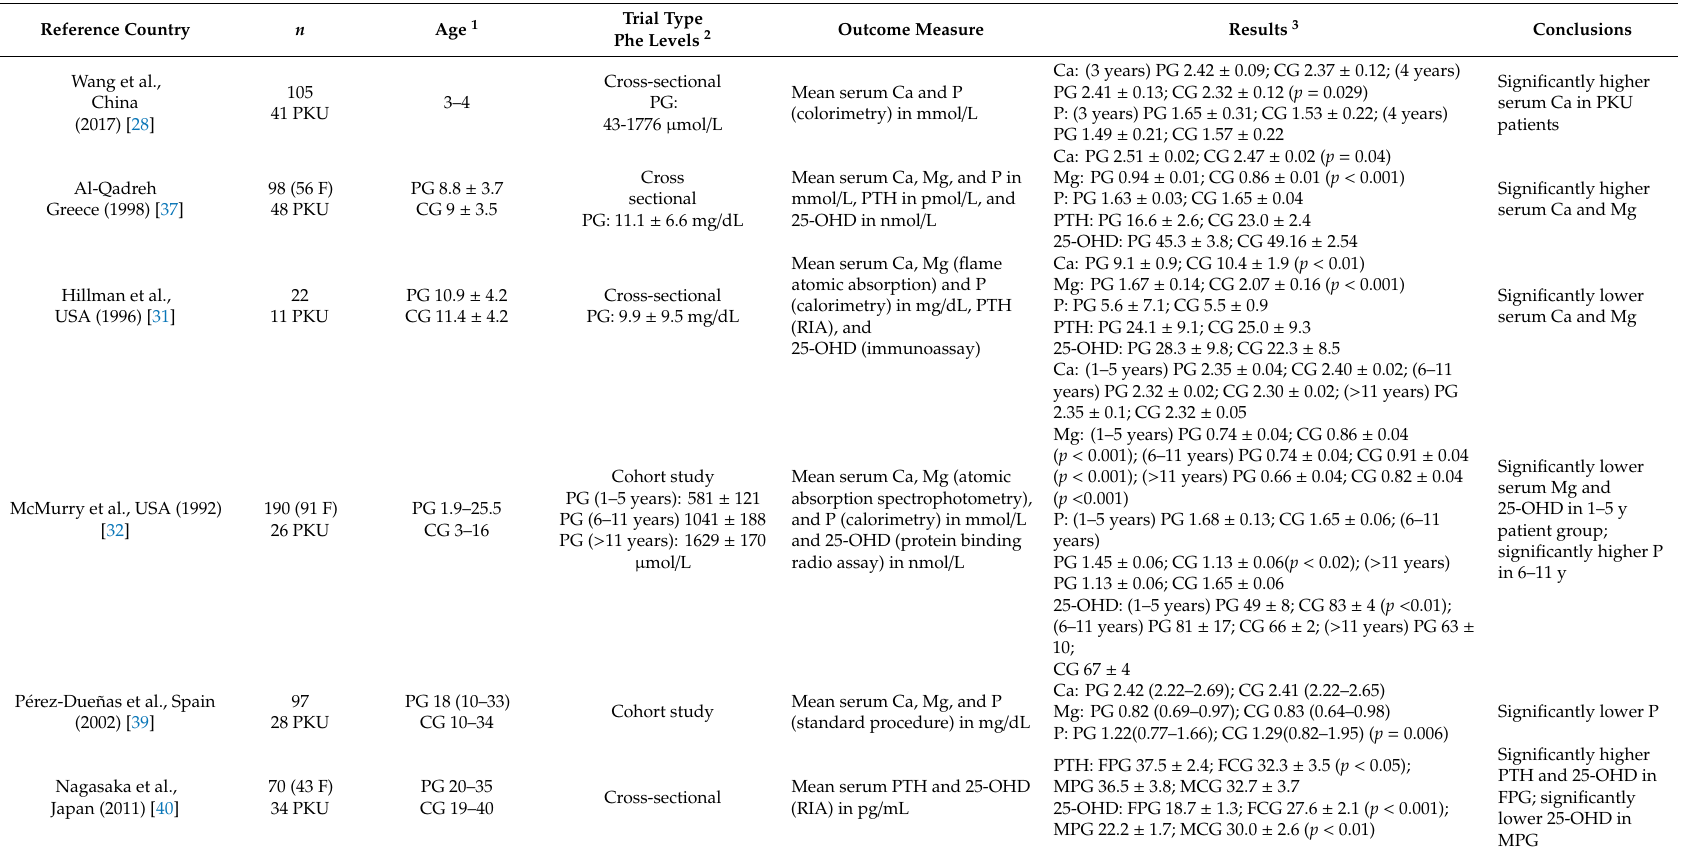
Table 4. Serum minerals and hormones in patients with